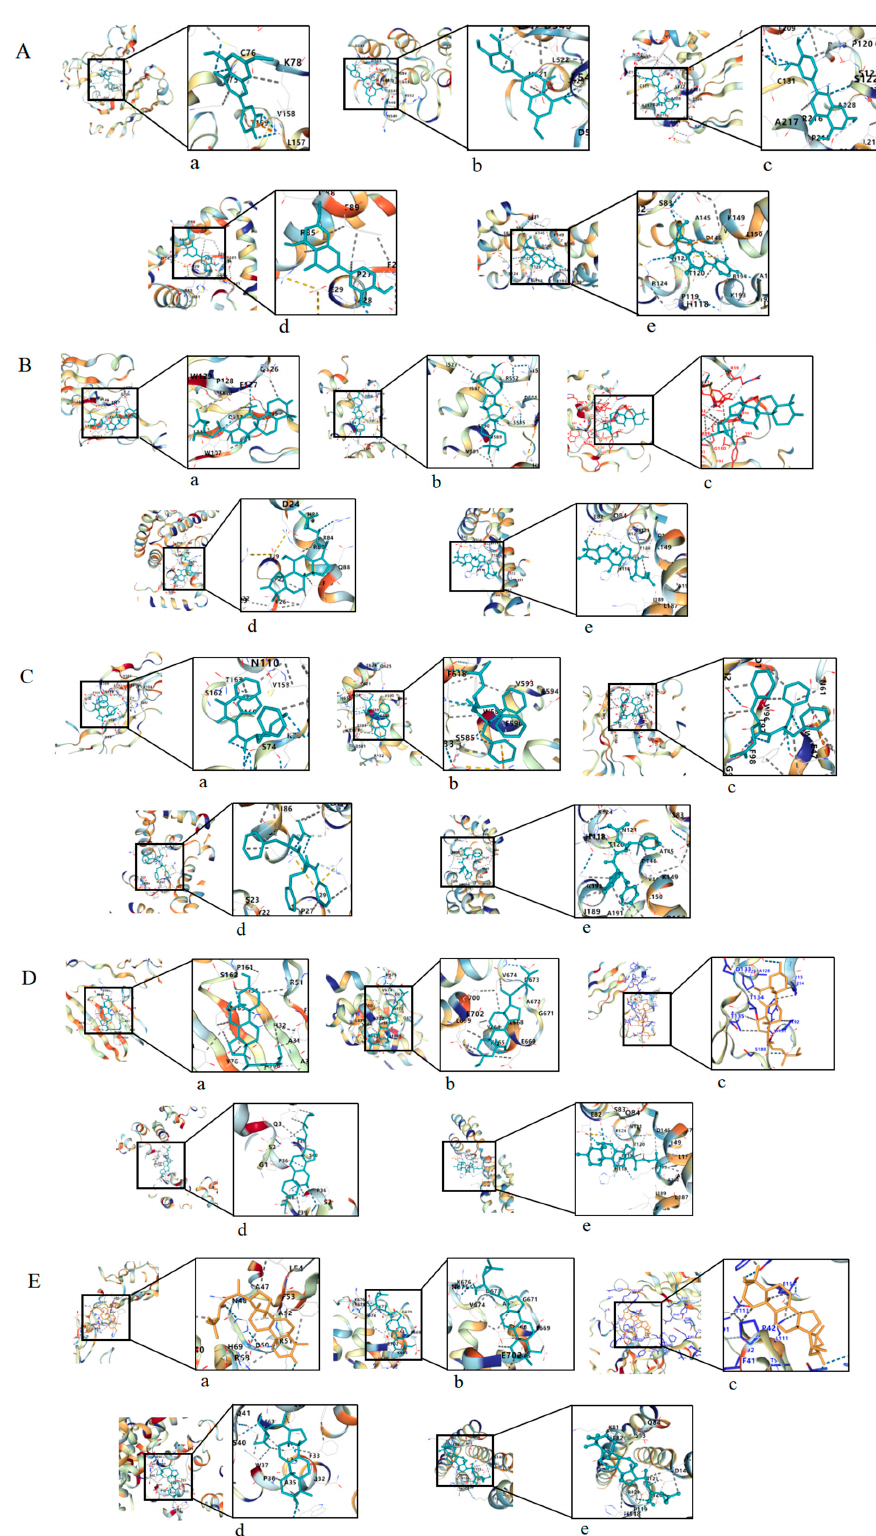
Figure 9. Molecular docking. (( A )—a, b, c, d, e: Hydroxygenkwanin-TNF, AKT1, EGFR, STAT3, CTNNB1) (( B )—a, b, c, d, e: Alisol B-TNF, AKT1, EGFR, STAT3, CTNNB1) (( C )—a, b, c, d, e: asper- glaucide-TNF, AKT1, EGFR, STAT3, CTNNB1) (( D )—a, b, c, d, e: Cerevisterol-TNF, AKT1, EGFR, STAT3, CTNNB1) (( E )—a, b, c, d, e: niloticin-TNF, AKT1, EGFR, STAT3, CTNNB1).